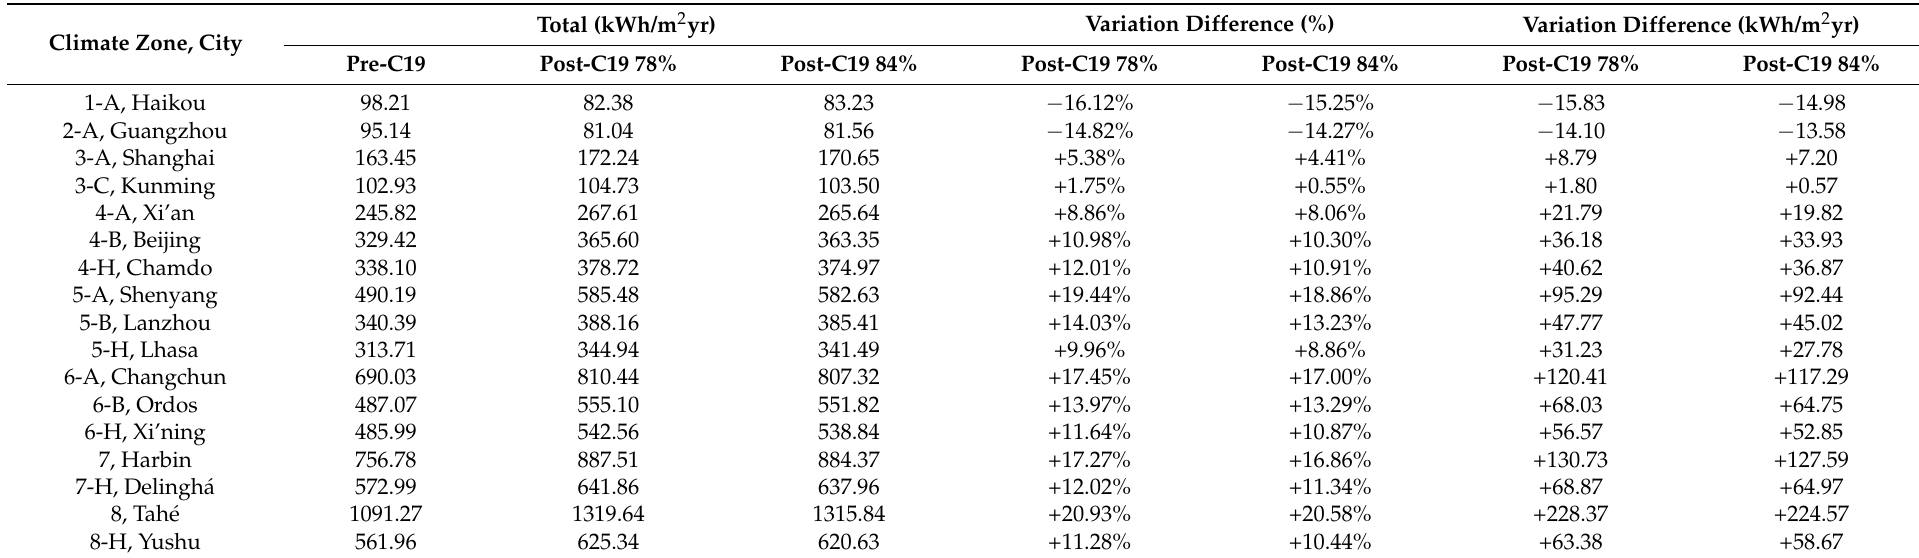
Table A4. Usable energy consumption per location (kWh/m 2 yr) in pre- and post-C19 scenarios. Climate Zone,